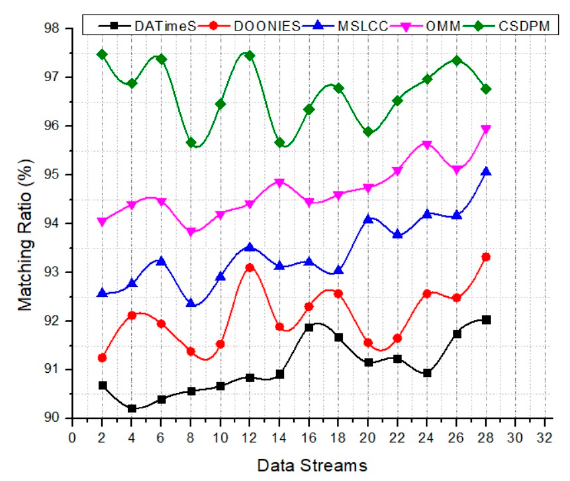
Table 1. Comparative analysis for data